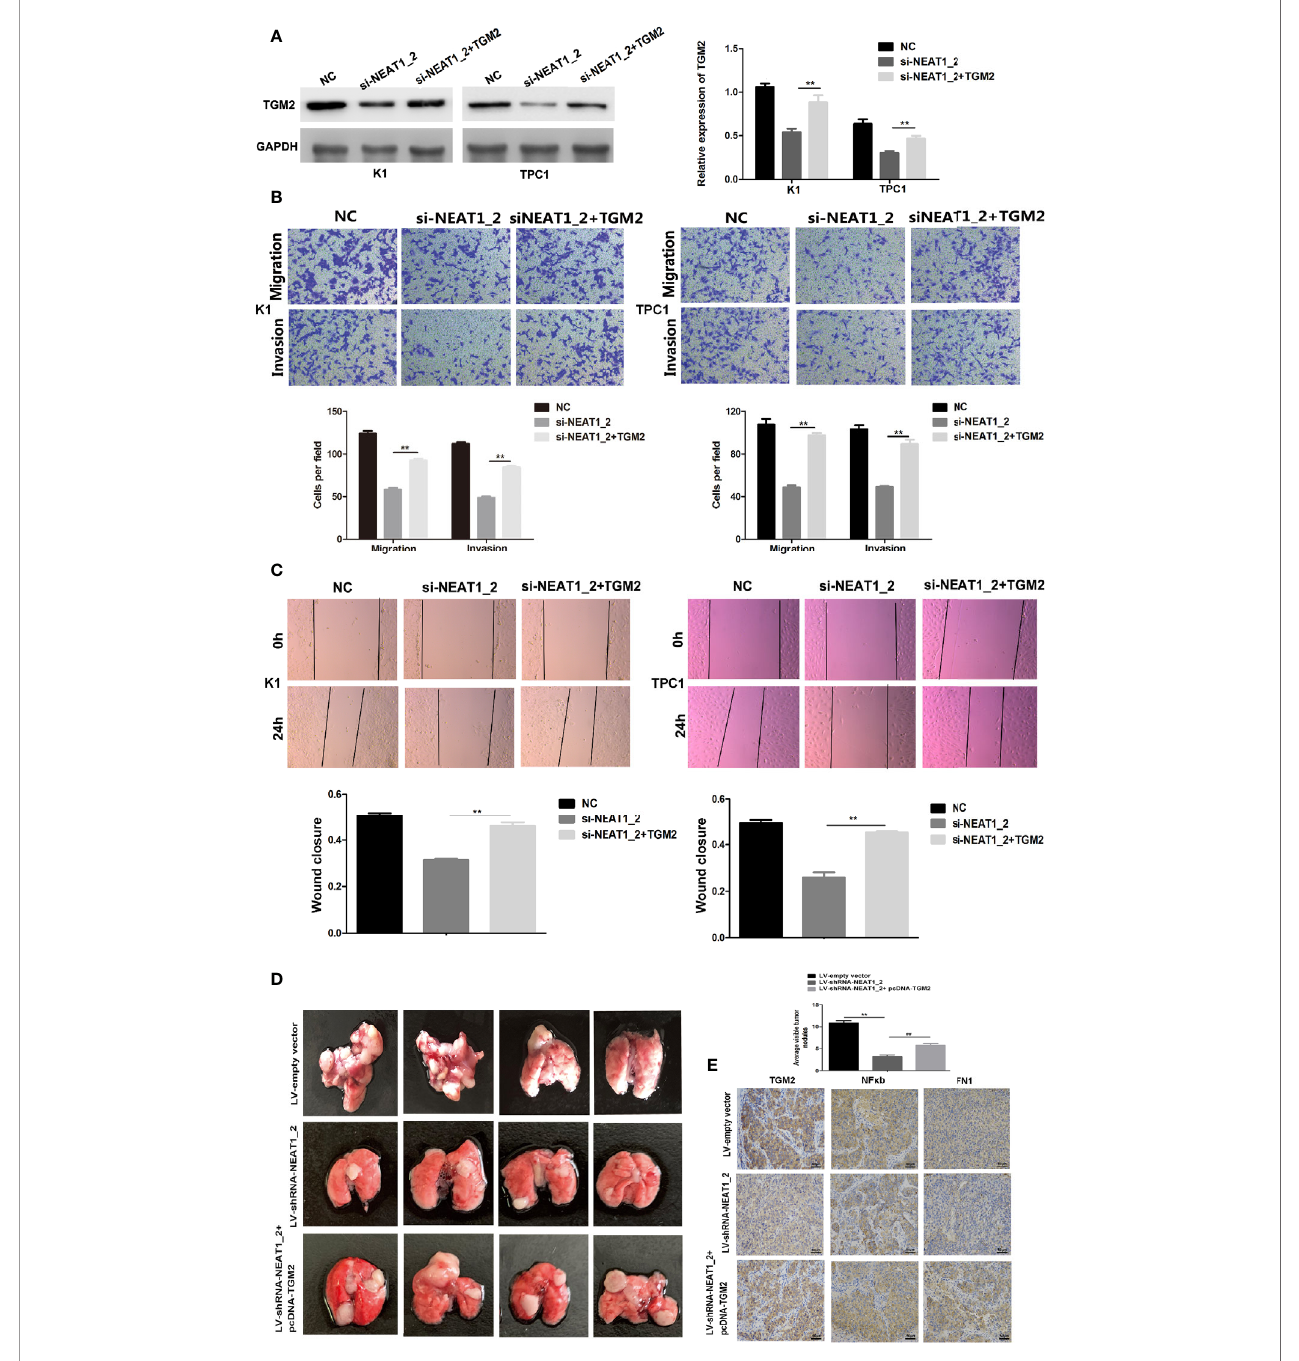
FIGURE 3 | Overexpression of TGM2 partially impairs NEAT1_2 depletion-mediated migration and invasion in PTC cells or in vitro. (A) Western blotting was used to analyze the level of TGM2 in PTC cells transfected with si-NEAT1_2 or co-transfected pCDNA3.1-TGM2 and si-NEAT1_2 or NC. Data are presented as the mean ± S.D., as analyzed using an independent samples t-test. **P < 0.01 versus NC. (B) Transwell assay analysis was used to evaluate the migration and invasion of PTC cells after transfection with si-TGM2 or after co-transfection pCDNA3.1-TGM2 and si-NEAT1_2 or NC. Data are presented as the mean ± S.D., as analyzed using an independent samples t-test. **P < 0.01 versus the si-NEAT1_2 group. (C) A wound healing assay was applied to analyze the migratory capacity of PTC cells after transfection with si-NEAT1_2 or co-transfected pCDNA3.1-TGM2 and si-NEAT1_2 or NC. (D) Lung metastasis nodules from model mice after intravenous injection of 1 × 10 6 K1 cells of the LV-sh-NEAT1_2 group, the LV-empty vector group, and the LV-shRNA-NEAT1_2 + pcDNA-TGM2 group. Data are presented as the mean ± S.D., as analyzed using an independent samples t-test. **P < 0.01 versus LV-empty vector group, ## P < 0.01 versus LV-sh-NEAT1_2 group. (E) IHC staining to analyze FN1, NF k b, and TGM2 expression in the mouse lung